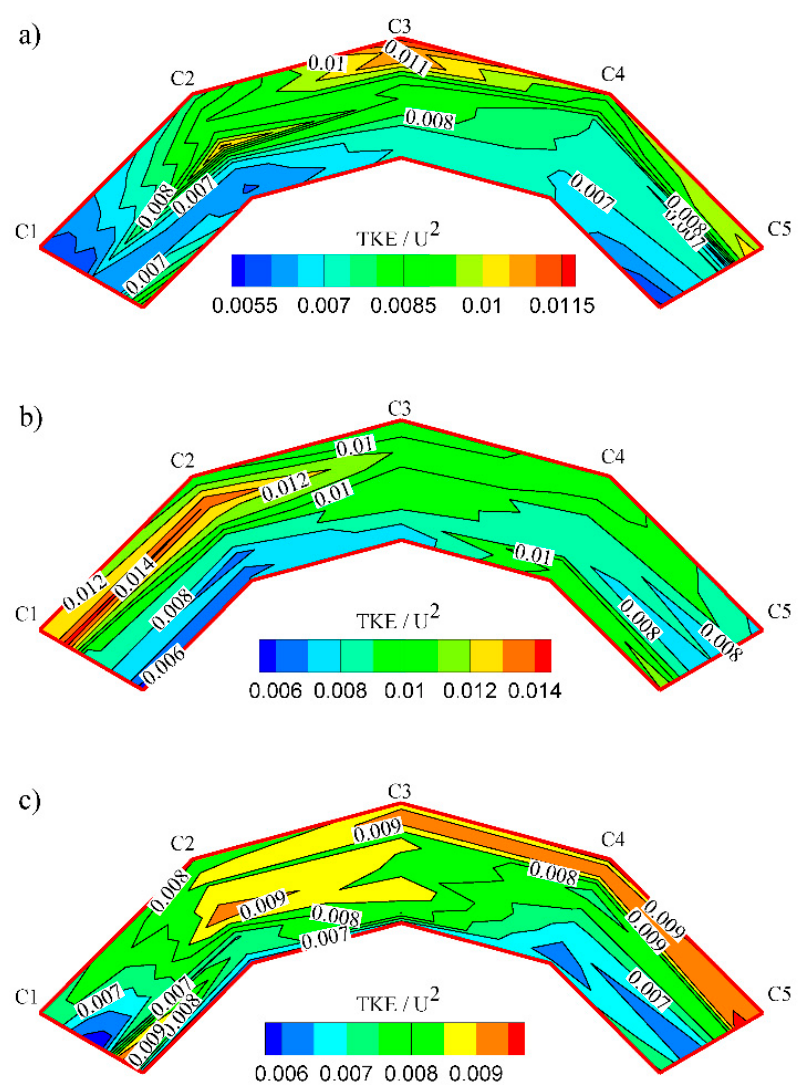
Figure 10. Normalized turbulent kinetic energy ( TKE / U 2 ) near-bed: ( a ) Test 4 (without cylindrical rods), ( b ) Test 5 (Model SR) and ( c ) Test 6 (Model DR).